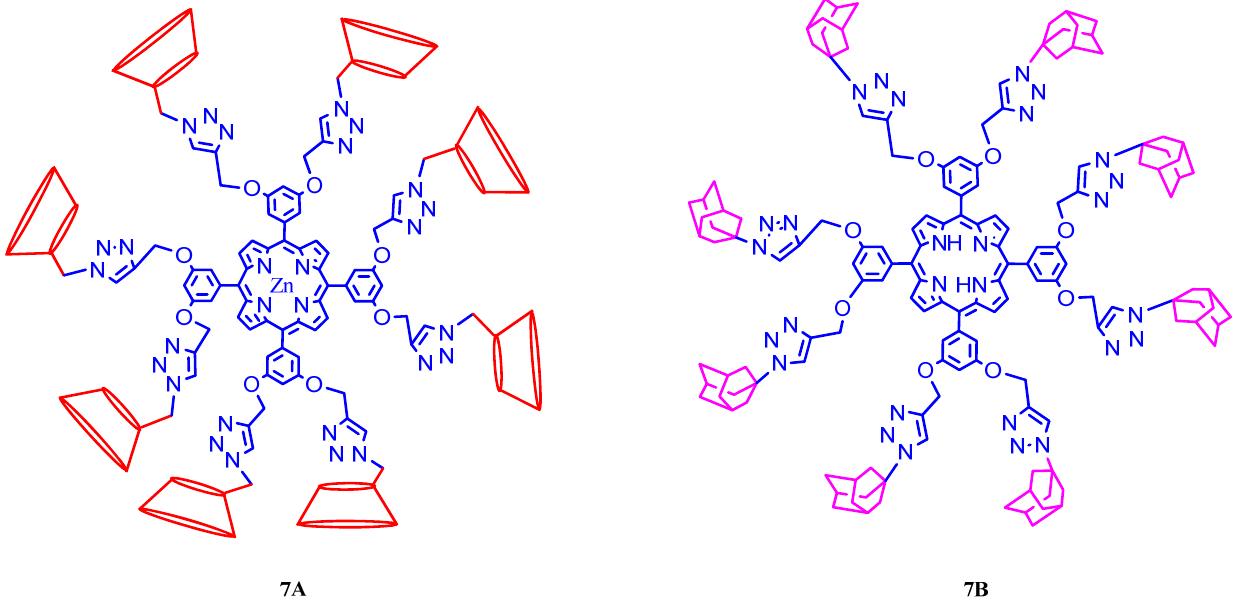
Figure 7. Porphyrin-cyclodextrin conjugate ( 7A ) and porphyrin-adamantane conjugate ( 7B) employed to generate porphyrin